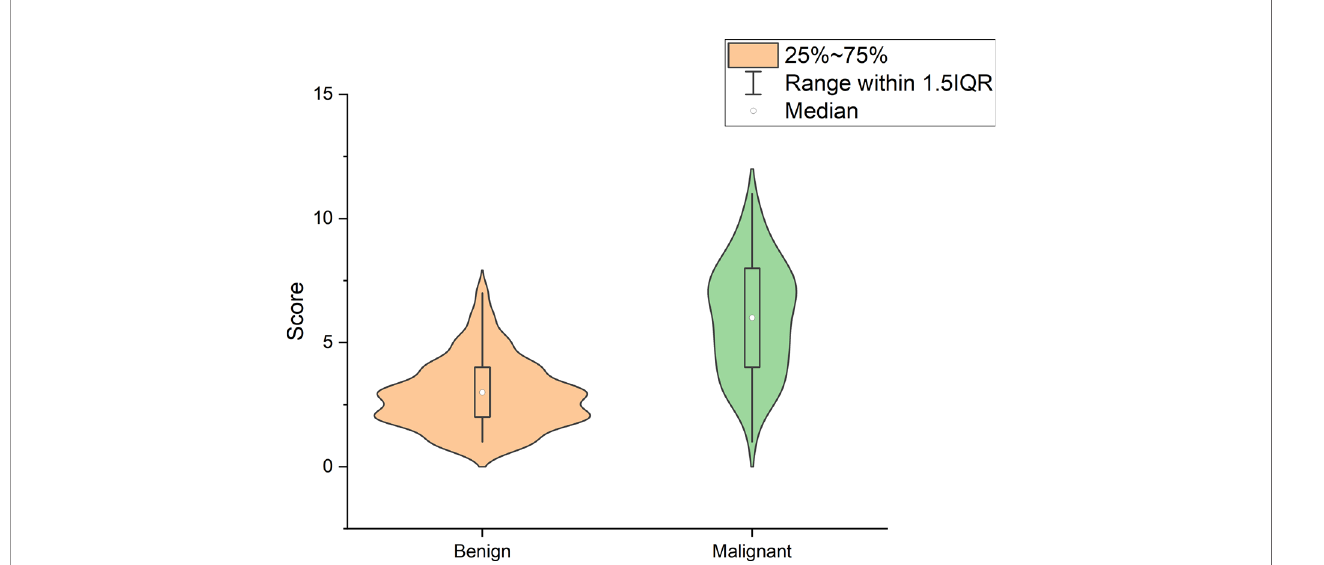
FIGURE 4 | The distributions of all PCTNs in the primary cohort in the scoring system shows as Violin plot.